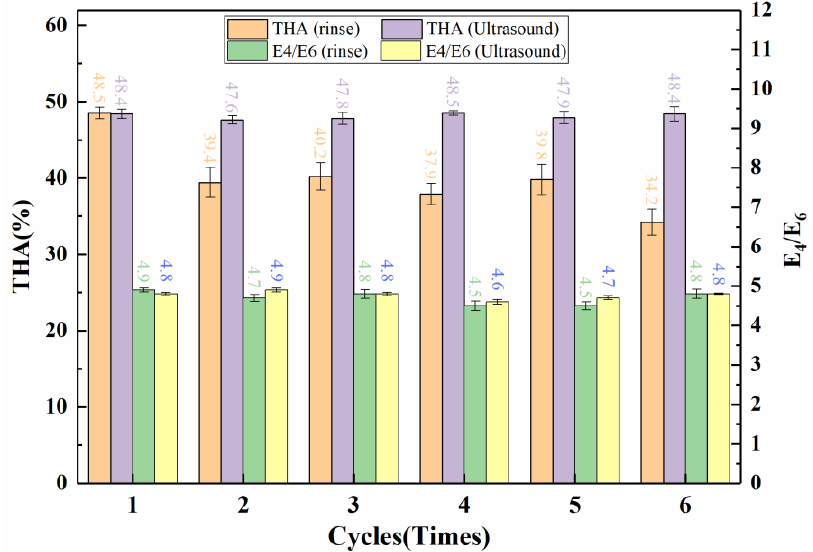
Figure 11. Recycling performance of Fe 3 O 4 /LaNiO 3 catalyst.